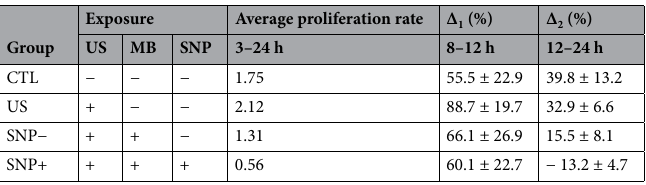
Table 1. Assessment of proliferation rates of the four sorted cell